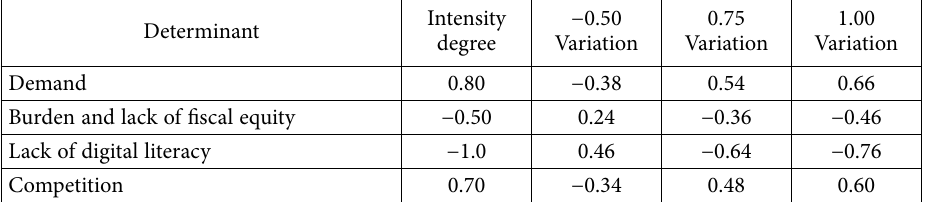
Table 5. Analysis of market